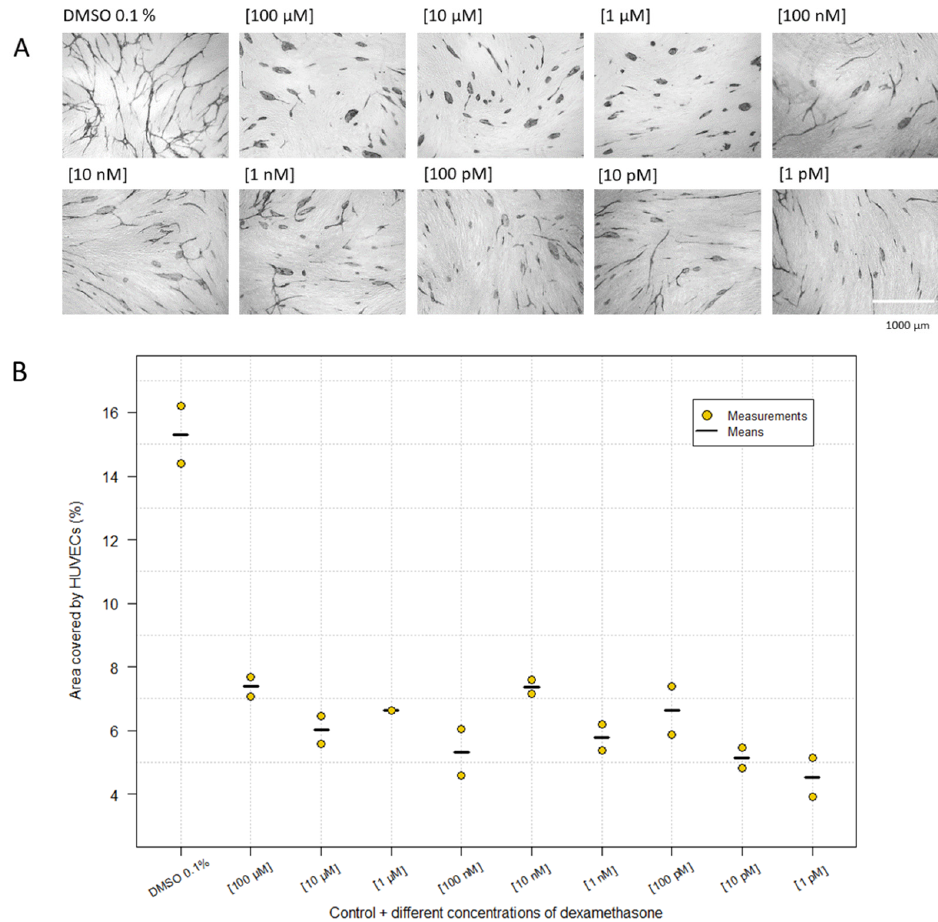
Figure 5. Effect of dexamethasone, in different concentrations, on HUVECs. The morphology ( A ) and area ( B ) of the HUVECs were visualized by immunostaining with CD31 MAb (magnification: 4 × ). ( B ) Image analysis shows the effect of dexamethasone on the percentage of area covered by HUVECs. Data are based on two independent experiments, which were carried out in duplicate. Kruskal–Wallis Χ 2 = 16.23. P = 0.062.